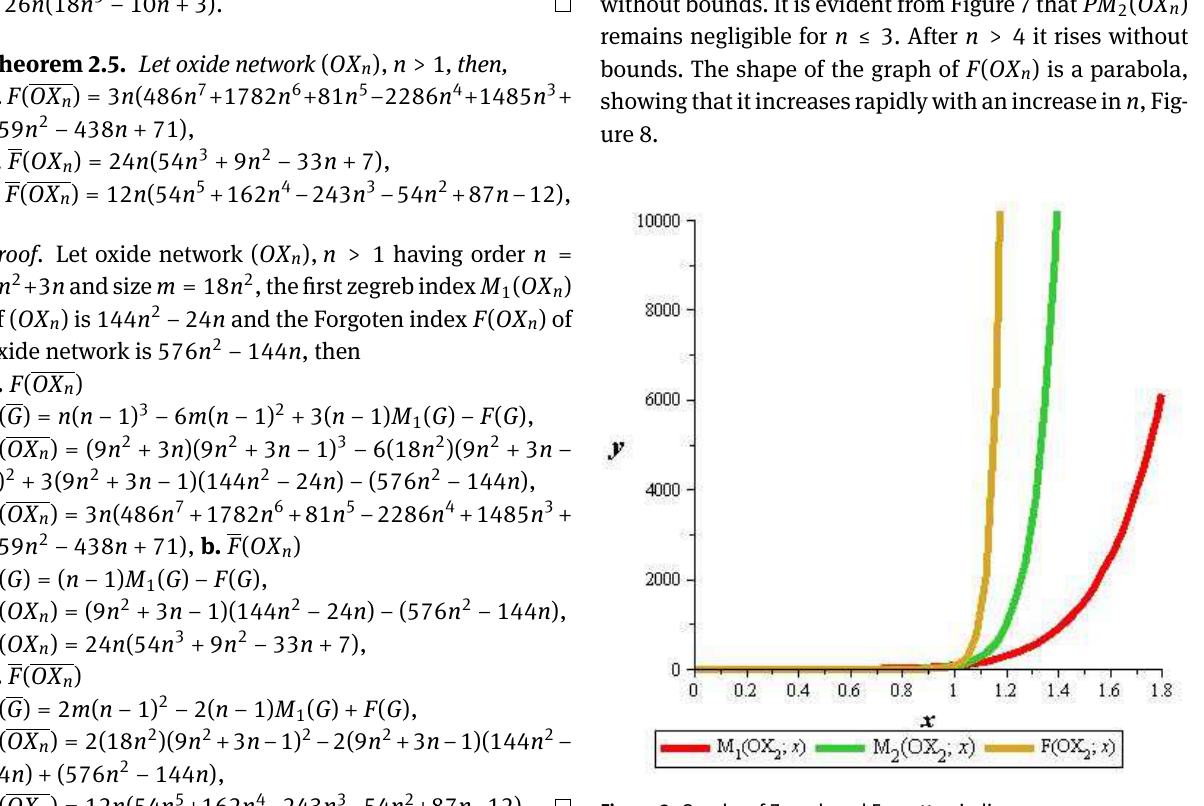
Figure 2: Graphs of Zagreb and Forgotten indices